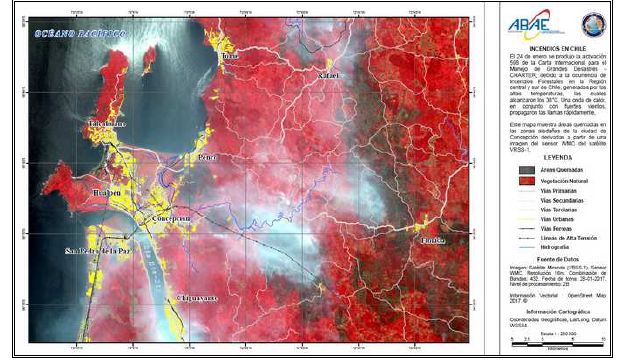
Figure N° 7: Affected Areas by Fire – Chile, Feb, 2017, using VRSS.1